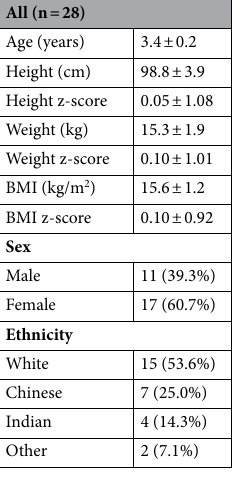
Table 1. Characteristics of the included cohort. Data are mean ± SD for continuous variables and n (%) for categorical variables.